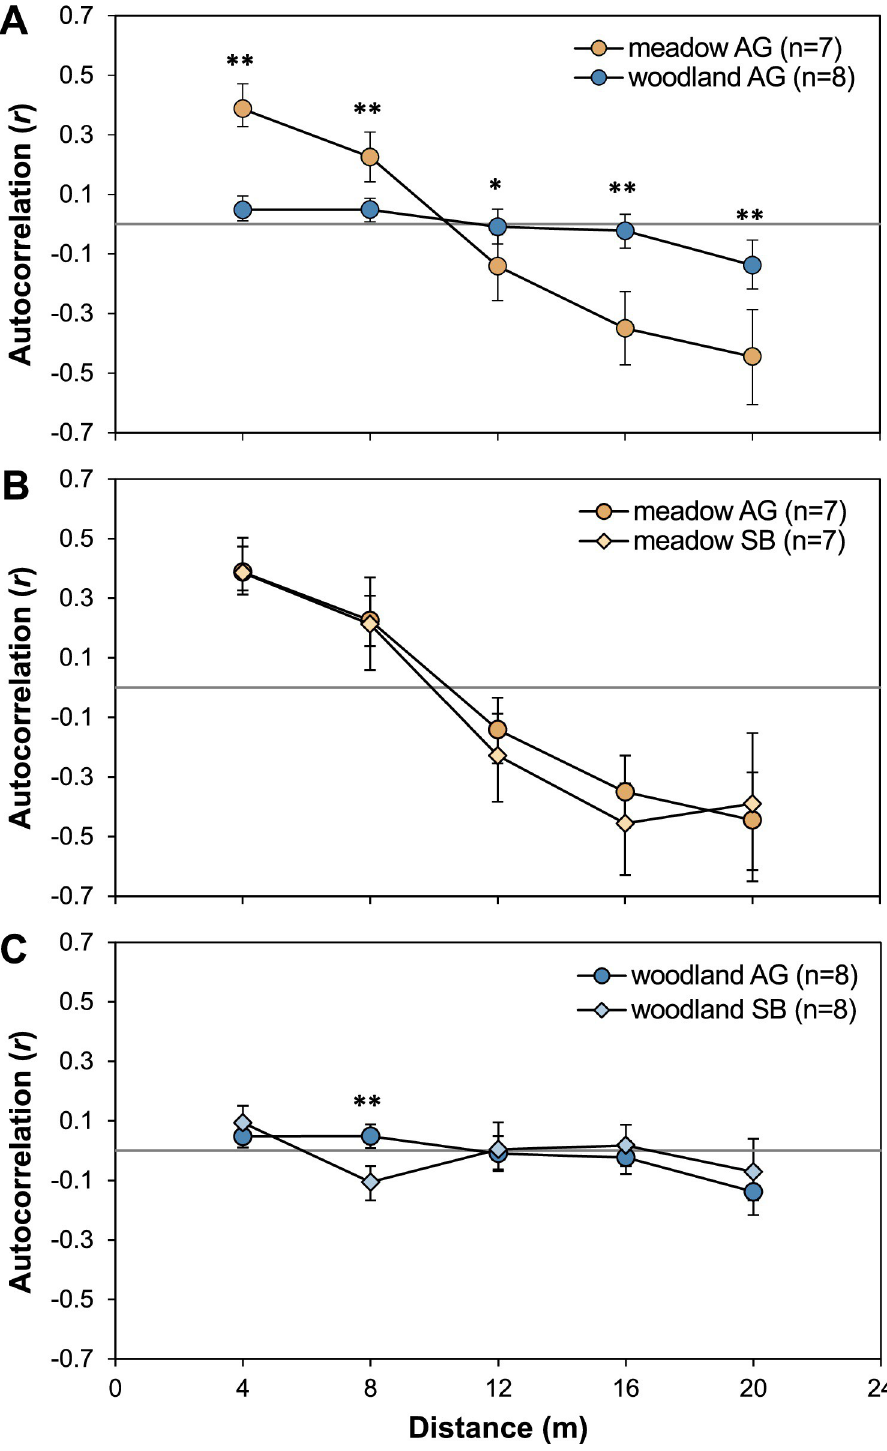
Fig 4. Correlograms of spatial genetic autocorrelation in populations of Viola elatior . Comparison of correlogram homogeneity is shown for (A) aboveground populations grouped for habitats, and for aboveground and seed bank populations from either only (B) meadow or (C) woodland habitats; ω -test indicates overall significance (A: ω = 73.74, p = 0.0001; B: ω = 9.33, p = 0.497; C: ω = 19.85, p = 0.030). � p < 0.05 and �� p < 0.01 indicate significant differences for single distance classes. AG—aboveground; SB–seed